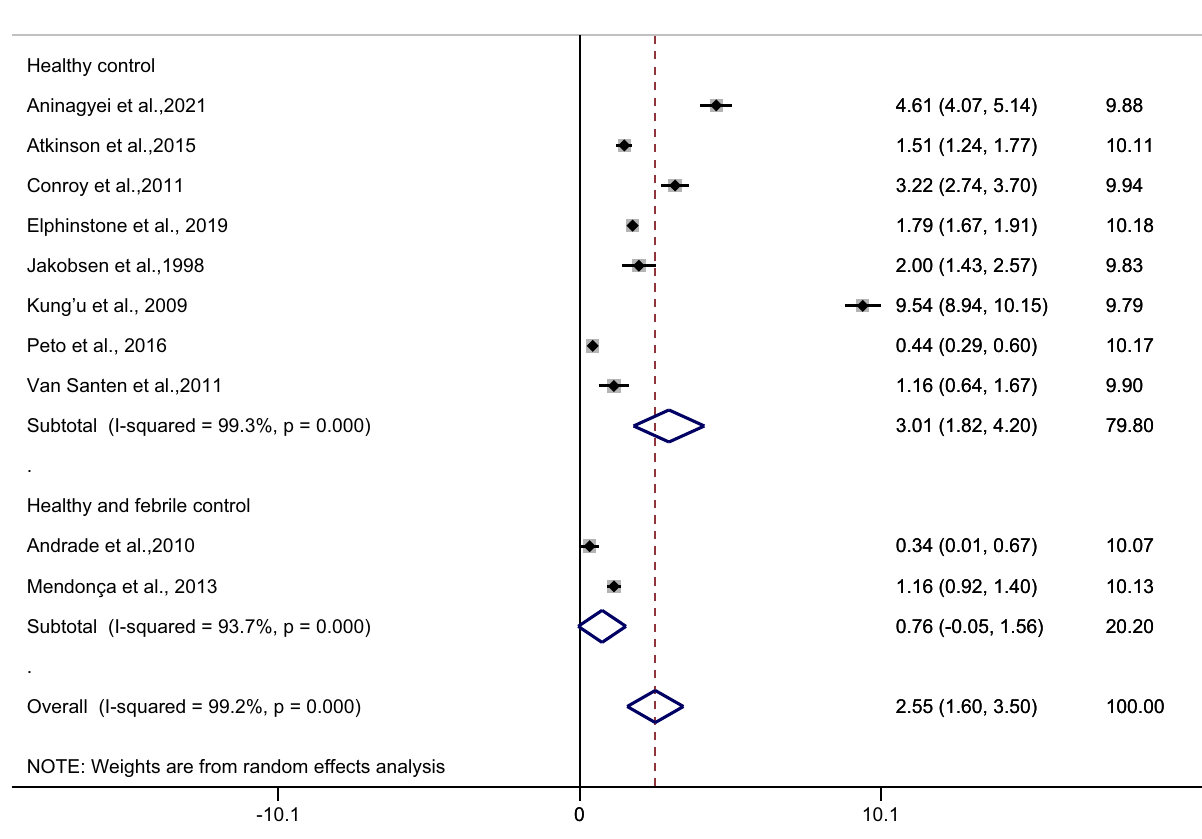
Figure 9. Forest plot demonstrates the difference in the mean CRP level between patients with asymptomatic malaria and healthy/febrile controls. SMD, standard mean difference; CI, confidence